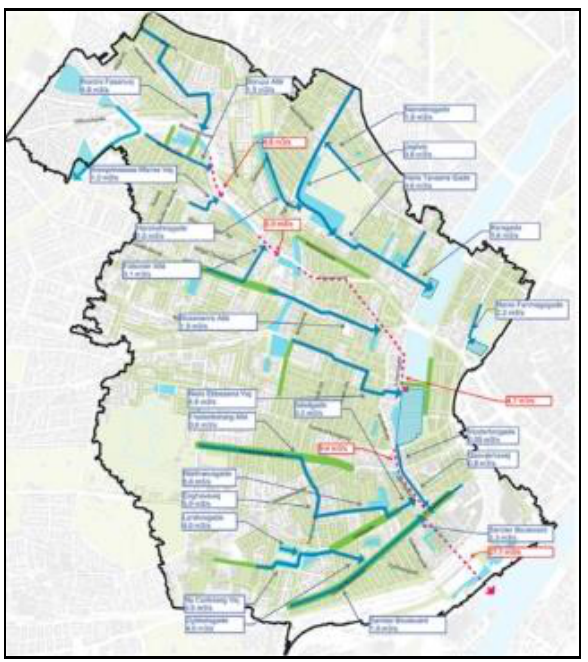
Figure 2 . Conceptual cloudburst plan for Copenhagen city